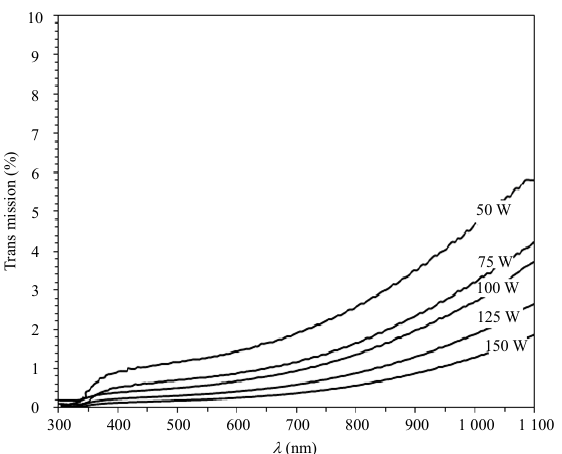
Fig. 3 Transmittance as a function of wavelength for (Ti6Al4V) thin film at different working RF powers.